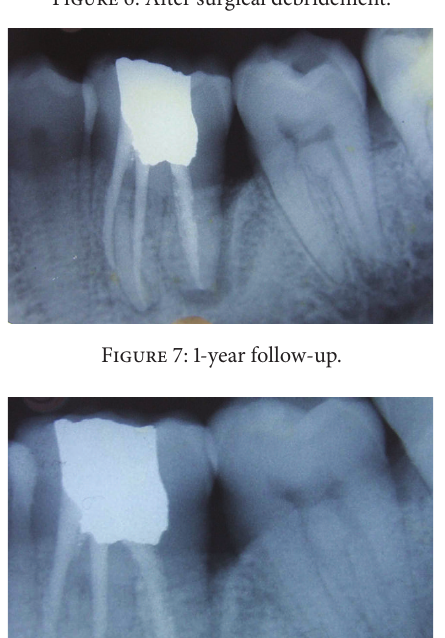
Figure 6: After surgical debridement.